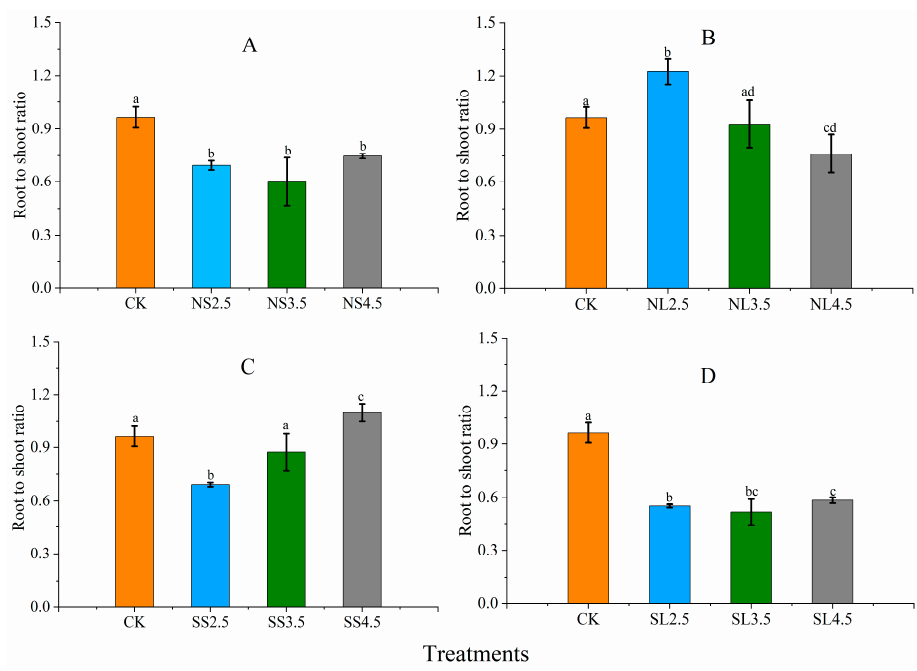
Figure 4. Effect of different forms of acid stress on root-to-shoot ratio (RSR) of A. catalpifolium . The treatments: CK, NS ( A ), NL ( B ), SS ( C ) and SL ( D ) are defined as control, nitric-balanced acid applied to soil, nitric-balanced acid applied to leaves, sulfuric-dominated acid applied to soil and sulfuric- dominated acid applied to leaves, respectively. Values are the average ± standard deviation (n = 10). Different letters above the error bars in each faceted plots indicated a significant difference ( p < 0.05) among different acidity within the same acid